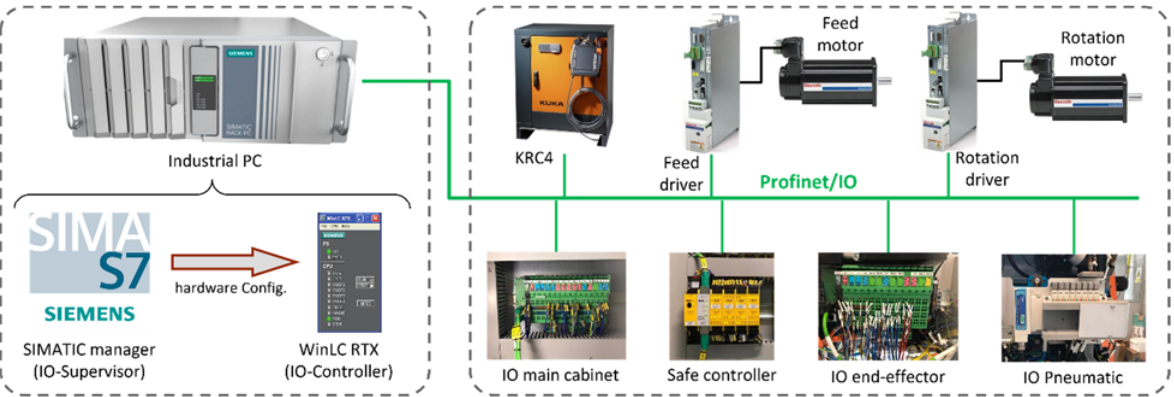
Figure 10. Profinet/IO as proximity network of the robotic cell. The industrial PC hosts IO-Supervisor and IO-Controller while IO-Devices are connected to industrial PC through Ethernet cable.